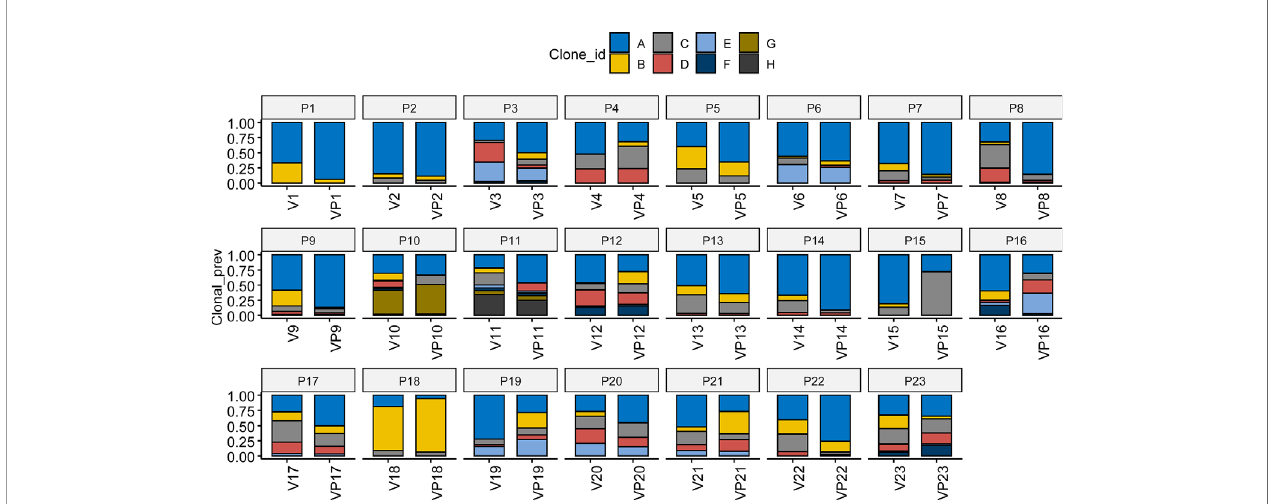
FIGURE 3 | Analysis of clonal phylogeny between the VTT and matched primary tumor. The constitution of subclones in each VTT and its matched primary tumor. V, VTT; VP, matched primary